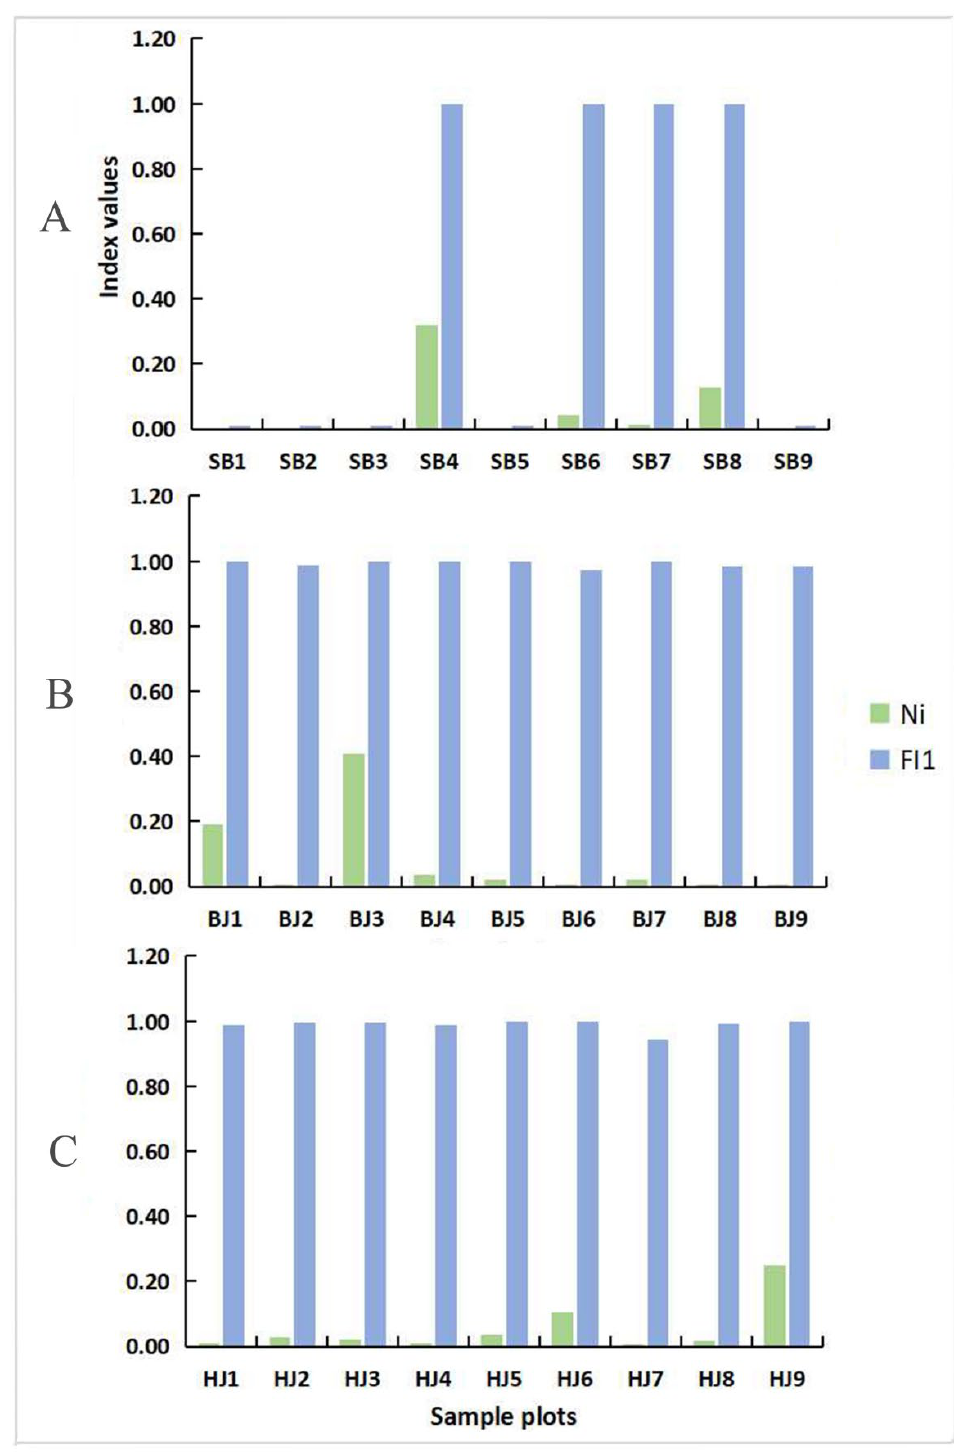
Figure 3. Habitat fragmentation index of Erythroneurine leafhoppers in the sample plots. (( A ): Shibing; ( B ): Bijie; ( C ): Huajiang; Ni : Separateness index; FI 1 : Inside habitat area fragmentation index).